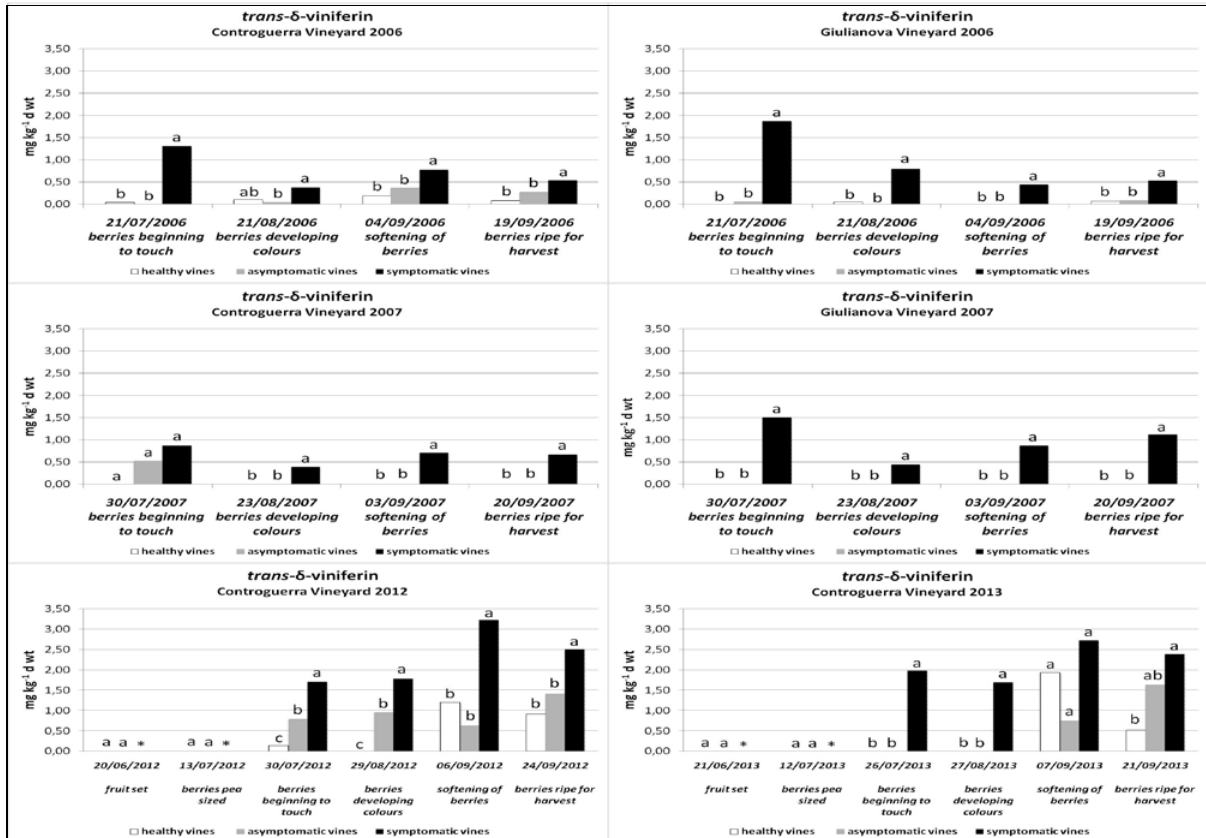
Figure 6. Levels of trans -δ - viniferin in the leaves of vines affected with GLSD and in leaves of healthy vines at various growth stages in the 2006, 2007, 2012 and 2013 growing seasons in the Controguerra and Giulianova vineyards. Statistical analysis was performed according to Tukey’s honest significant difference (HSD) test. Each grapevine category (symptomatic, asymptomatic and healthy) comprised 6 replications of leaf data (1 replication = 1 vine) in each growth stage, in each year and in each vineyard. Different letters represent significant differences at P = 0.05. * = no symptomatic vines found;